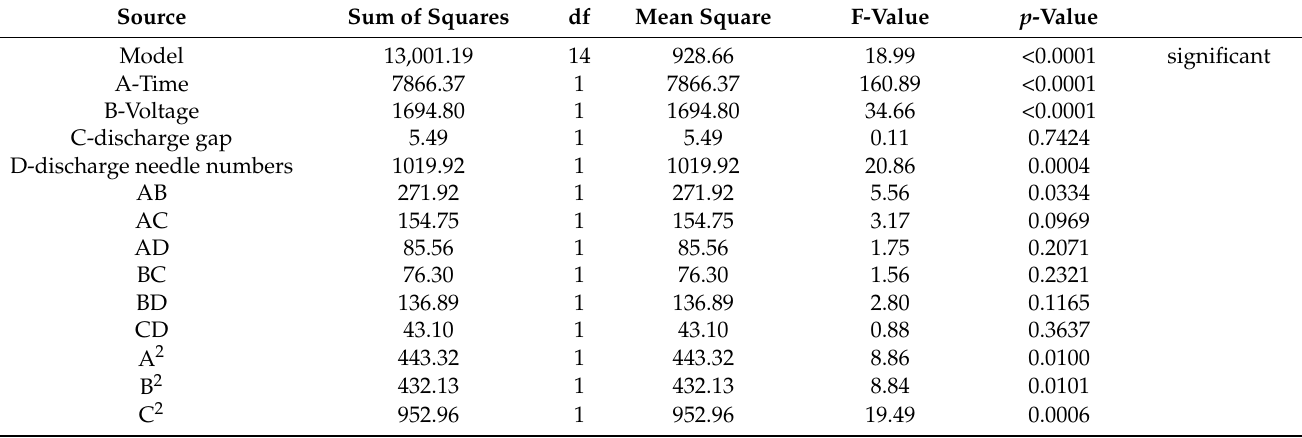
Table 3. MO ANOVA results for response surface of quadratic